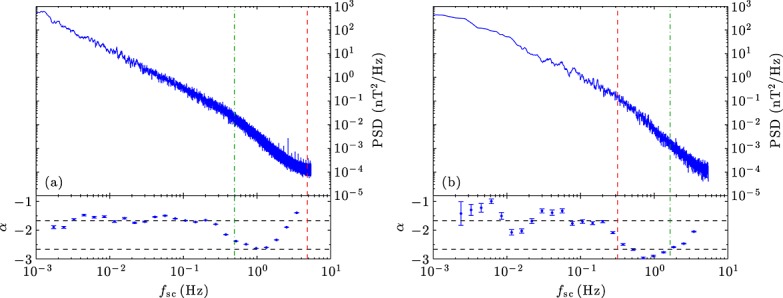
(a) Magnetic power spectrum and local slope α for β⊥i=0.010 (19 January 2005 11:00–24:00). (b) Same for β⊥i=27 (23 September 2001 22:16–22:41). Frequencies corresponding to kρi=1 (red dashed line) and kdi=1 (green dash-dotted line) are marked. In both cases, the break occurs at the larger of the scales.